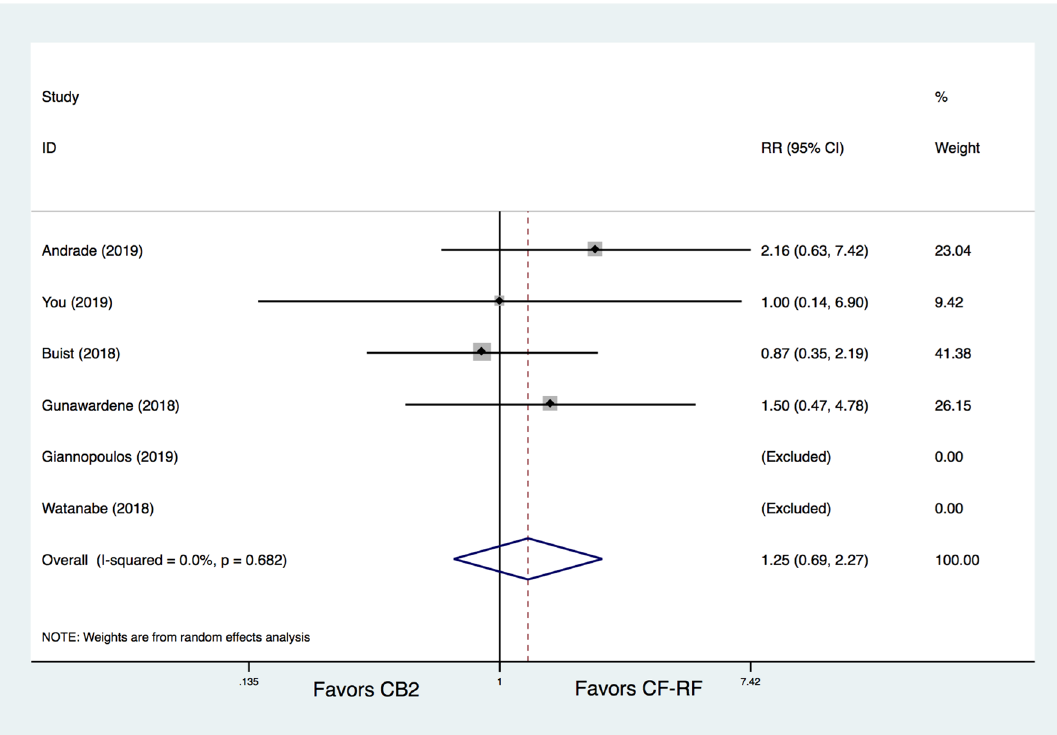
Figure 4. Meta-analysis for the outcome of total complications. CF-RF = contact force radiofrequency ablation; CB2 = cryoballoon ablation (CBA) with a second-generation cryoballoon; RR = relative